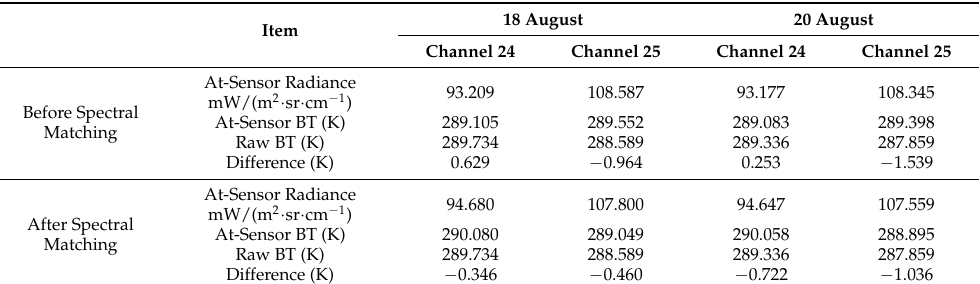
Table 3. The difference between the simulated brightness temperature and satellite-based brightness temperature before and after spectral